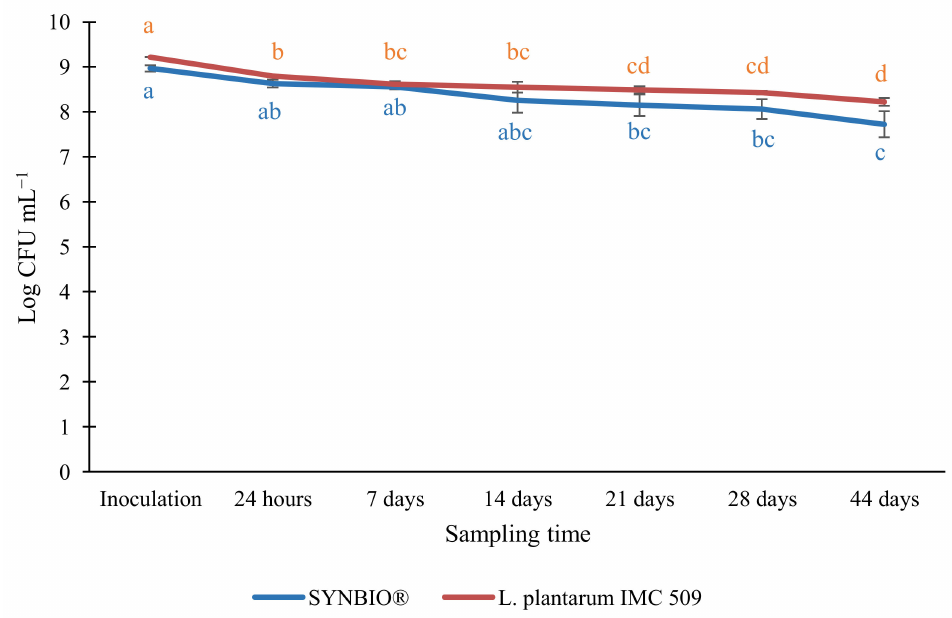
Figure 4. Results of the enumeration of Lactiplantibacillus plantarum IMC 509 (red line) and SYNBIO ® (blue line), a combination (1:1) of the strains Lacticaseibacillus rhamnosus IMC 501 ® and Lacticaseibacillus paracasei IMC 502 ® ), in an acidified sea fennel preserve, during a refrigerated storage of 44 days. Results are expressed as mean value of CFU mL − 1 ± standard deviation. Values labelled with different letters in the same growth curve are significantly different ( p < 0.05) by one-way ANOVA